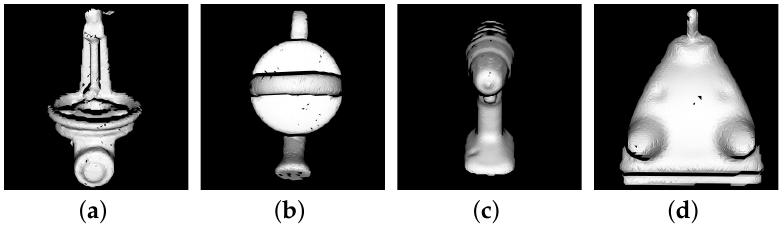
Figure 11. Selected template of ( a ) Benchvise; ( b ) Can; ( c ) Driller; ( d )